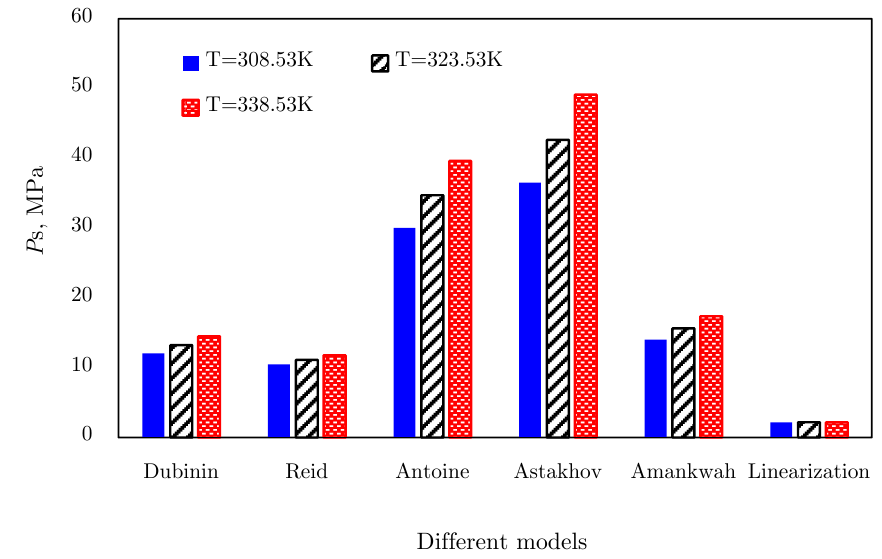
Figure 23. The calculated virtual saturated vapor pressure for Woodford shale at different temperatures.